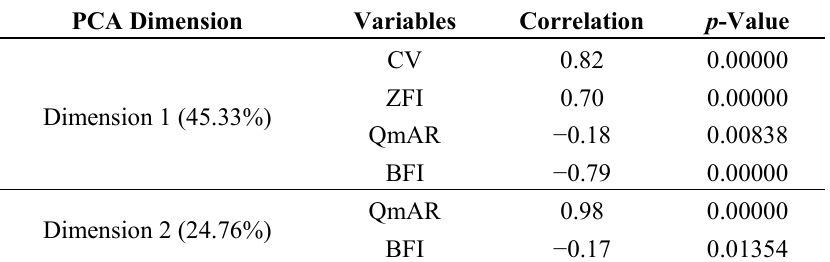
Figure 3. Variable factor and individual factor map of Principal Component Analysis (PCA). Table 2. Correlation and p -values of variables with the two dimensions of